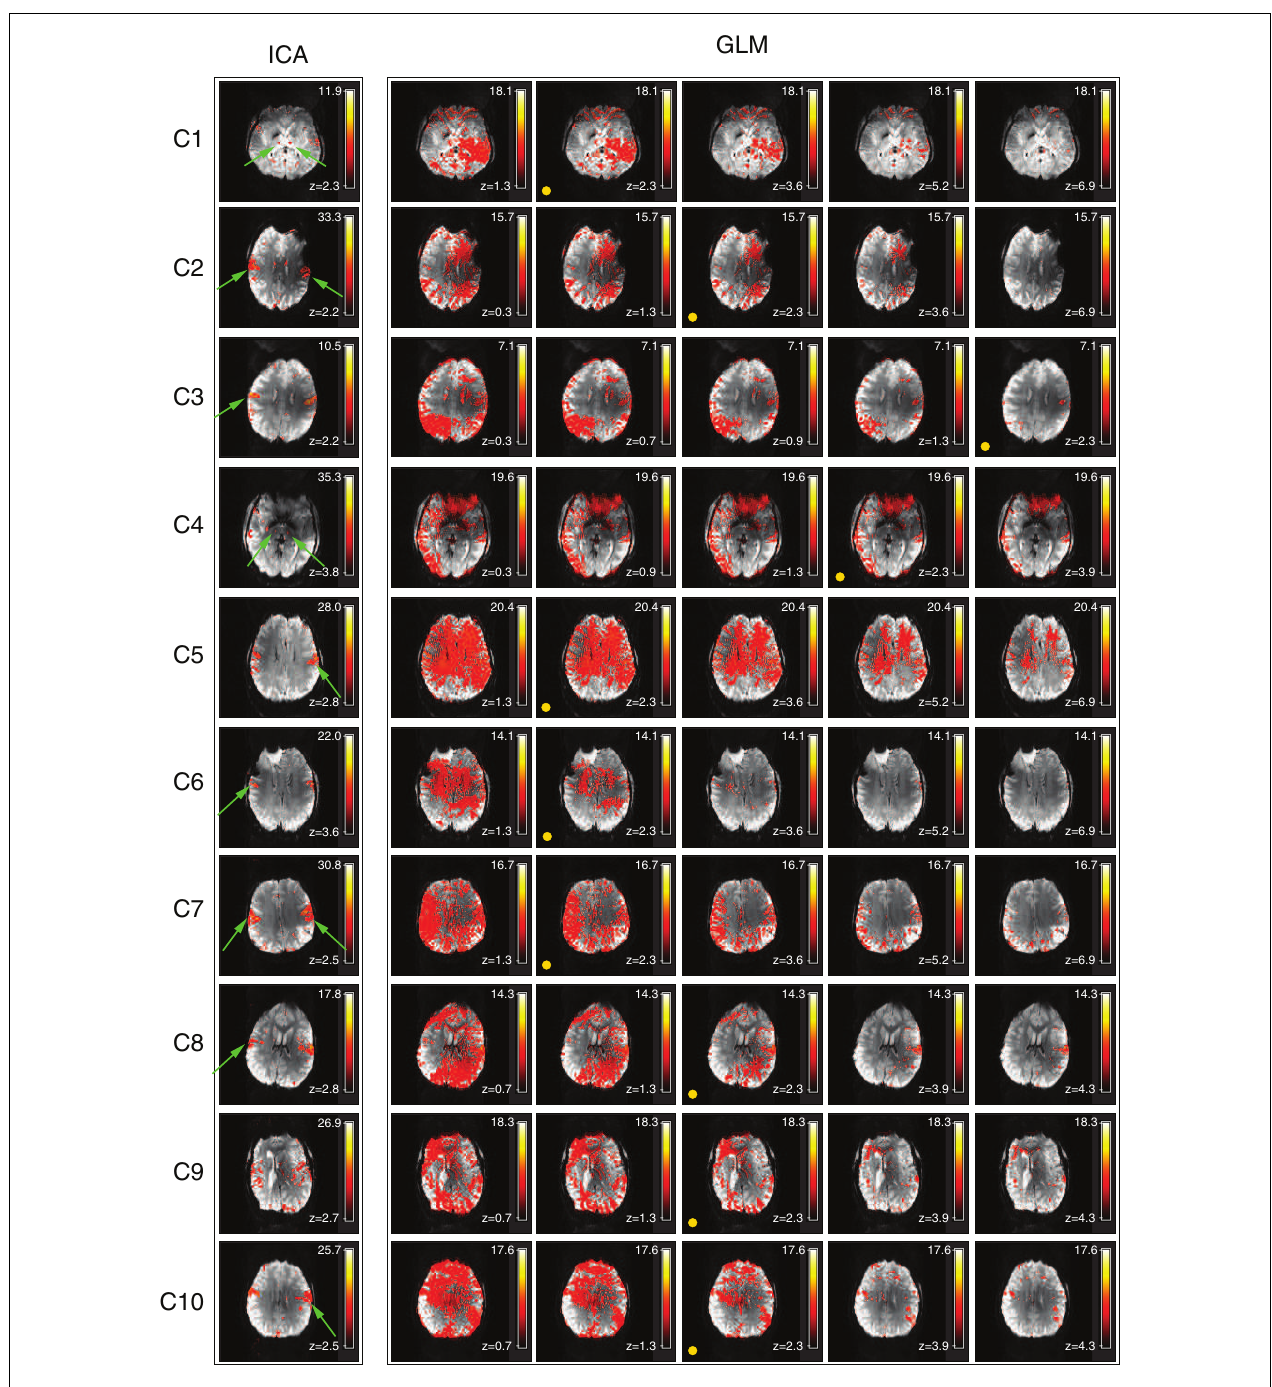
spot. Activation maps are illustrated at higher and lower thresholds than this to allow the ability to separate activation and motion in GLM results to be assessed. Clusters which are substantially better defined in ICA are indicated by green